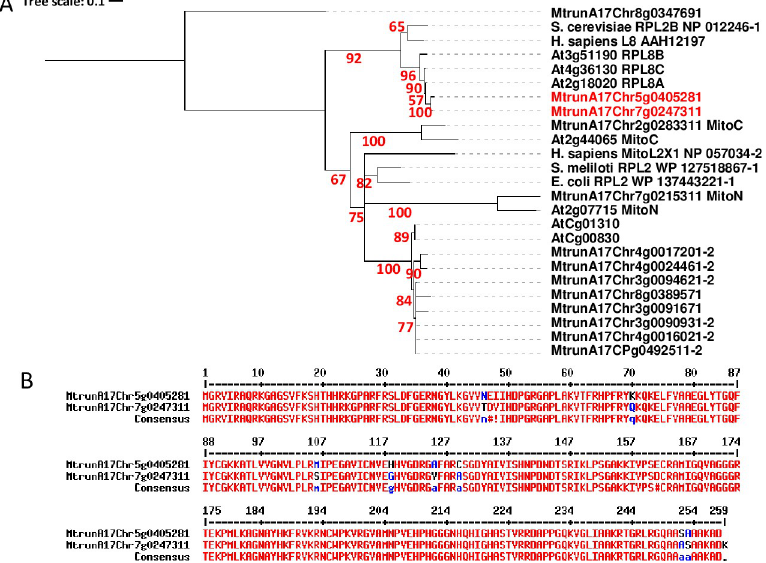
Fig 3. The MtRPuL2 protein family. Panel A: phylogenetic tree of RPuL2 protein sequences from Medicago truncatula (MtrunA17), Arabidopsis thaliana (At), Homo sapiens , Escherichia coli , Sinorhizobium meliloti and Saccharomyces cerevisiae . “MitoC” and “MitoN” refer to the C and N-terminal parts of mitochondrial proteins, respectively. “CP” and “C” refers to chloroplastic proteins. Original nomenclatures are kept (L2, L8). MtrunA17Chr7g0247311 (MtRPuL2A) and MtrunA17Chr5g0405281 (MtRPuL2B) proteins are in red. Branches with support values less than 0.5 were collapsed. The MtrunA17Chr8g00347691 RPuL5 protein used for specificity (Fig 5), was considered as an outgroup to root the tree. See methods for details. Panel B : sequence alignment of the MtrunA17Chr7g0247311 and MtrunA17Chr5g0405281 proteins (http://multalin.toulouse.inra.fr/multalin).